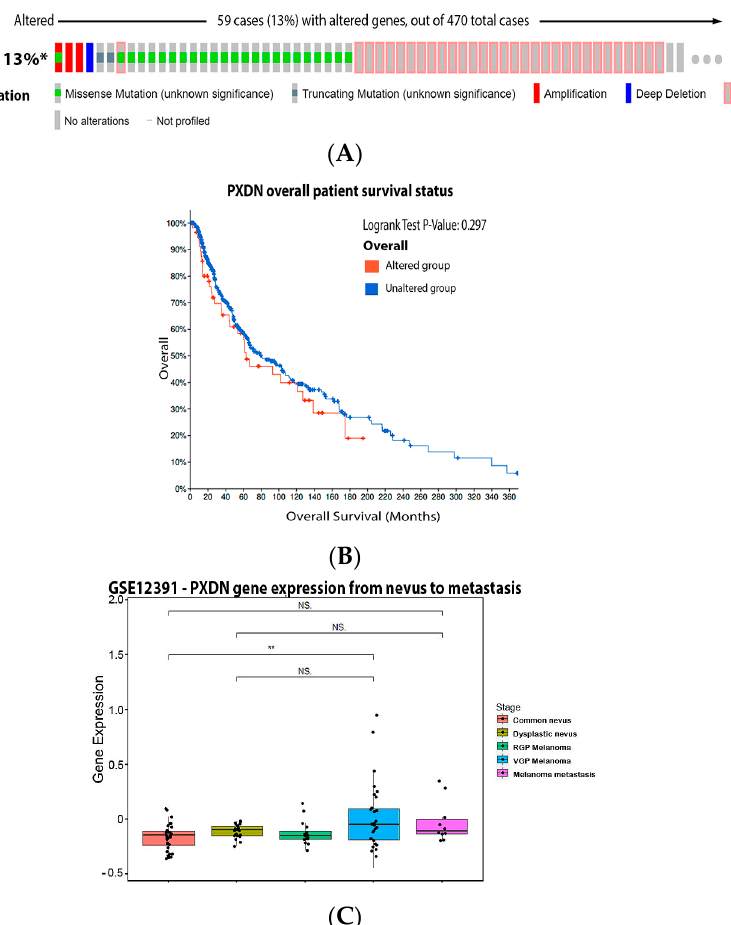
Figure 9. Peroxidasin on melanoma. ( A ) Percentage of patients with altered genes and types of genetic alterations; ( B ) overall patient survival status, and ( C ) expression in the melanoma progression. Red boxes represent the common nevus, yellow boxes the dysplastic nevus, green boxes the radial growth phase (RGP) melanoma, blue boxes the vertical growth phase (VGP) melanoma, and purple boxes the metastatic melanoma. The statistical analysis was performed by ANOVA followed by Tukey test, ** p < 0.01 * p < 0.05 when compared to common or dysplastic nevus. NS: Not